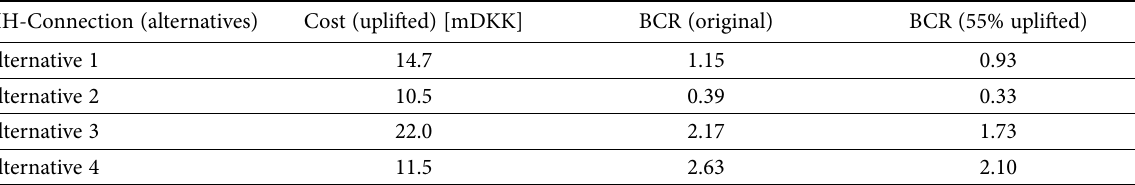
Table 5. Results from a deterministic run of the UNITE-DSS model applying the Optimism Bias uplifts with 80% certainty HH-Connection